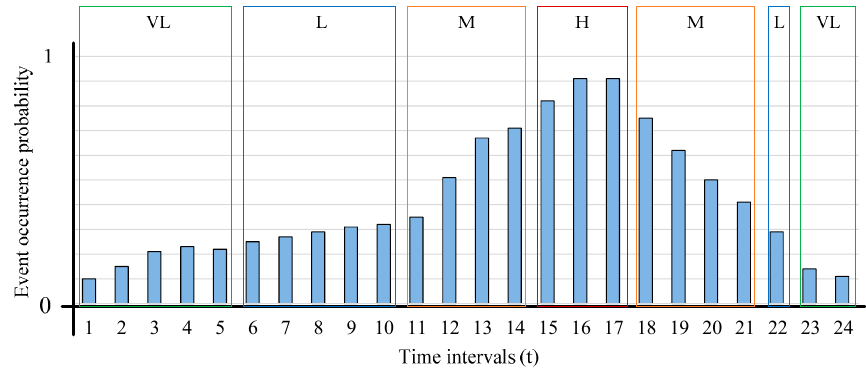
Figure 10. Simulated scenario for evaluating proposed strategy during normal mode operation.